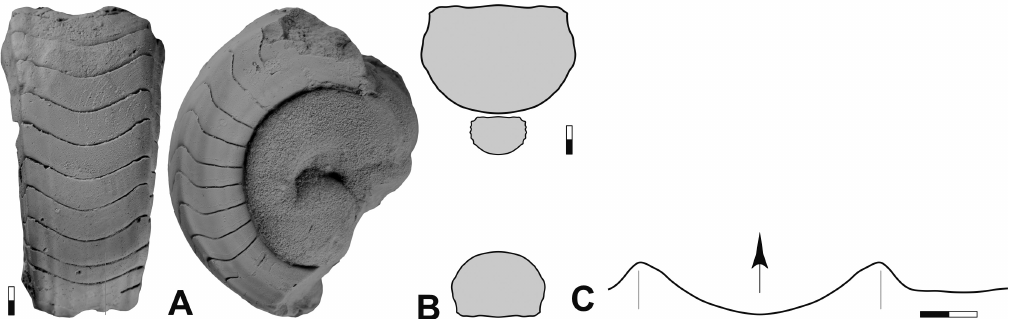
Fig. 10. Stroboceras mane sp. nov. from Oued Temertasset, holotype MB.C.30458.1 (Korn et al . 2002 Coll.). A . Ventral and lateral views. B . Cross section. C . Suture line, at ww = 9.9 mm, wh = 5.5 mm. Scale bar units = 1